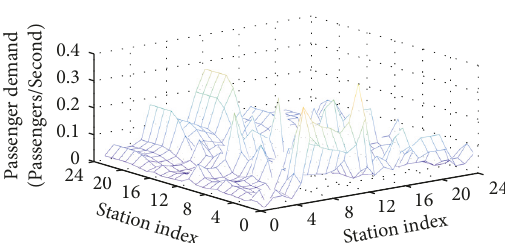
Figure 9: Baseline passenger demand for